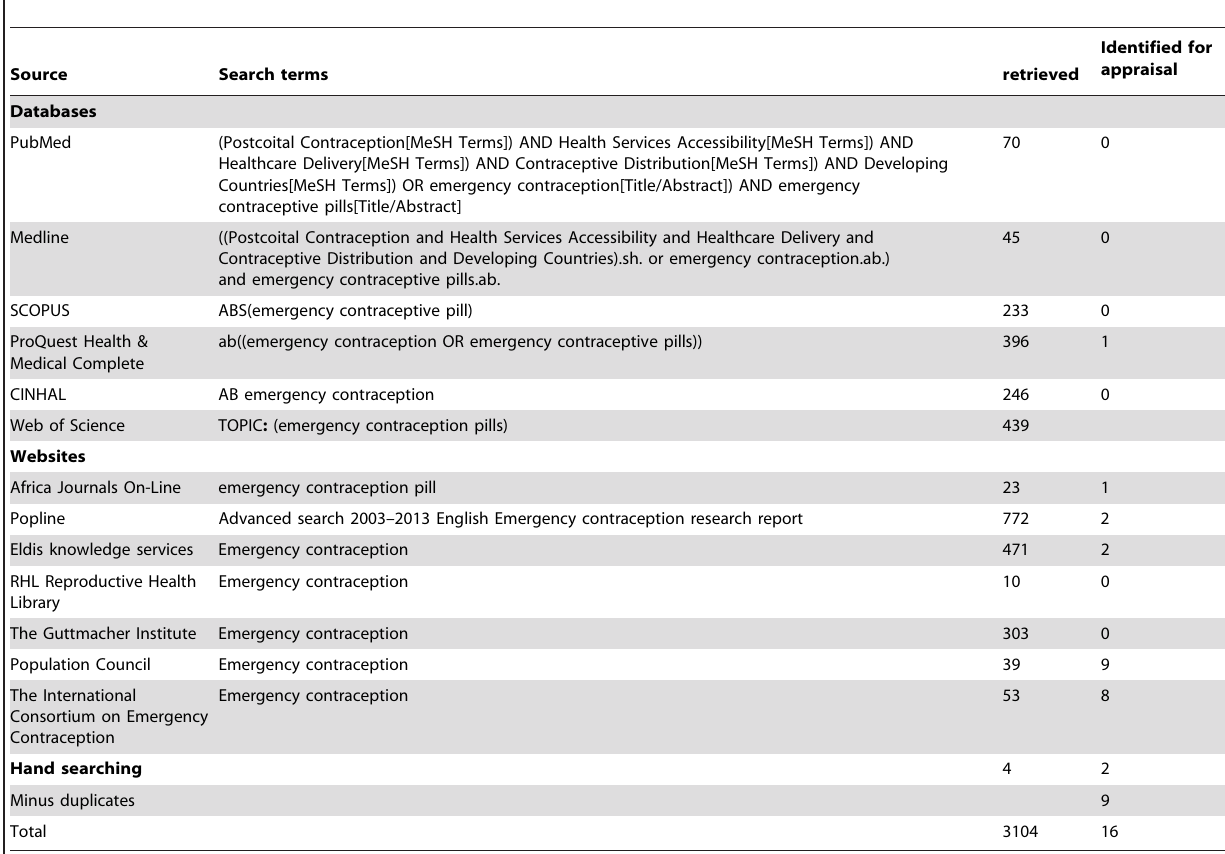
Table 1. Record retrieved from databases and internet